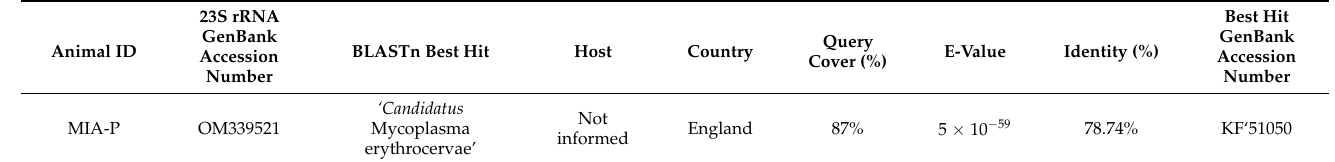
Table 5. BLASTn analysis of each partial hemoplasma dnaK sequence obtained from free-ranging tapirs from the Brazilian biomes of Cerrado and